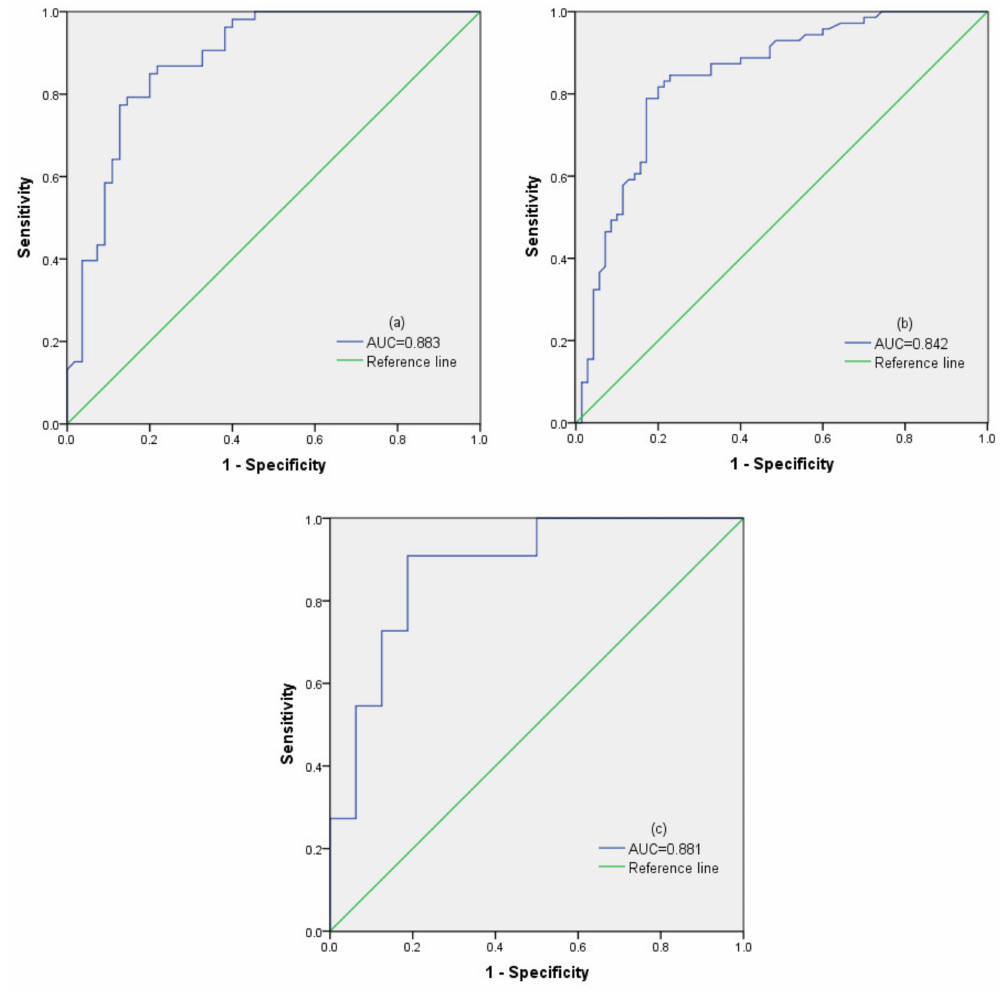
Figure 8. The ROC curves based on validation data: ( a ) The ROC curve of collapse. ( b ) The ROC curve of landslide. ( c ) The ROC curve of debris